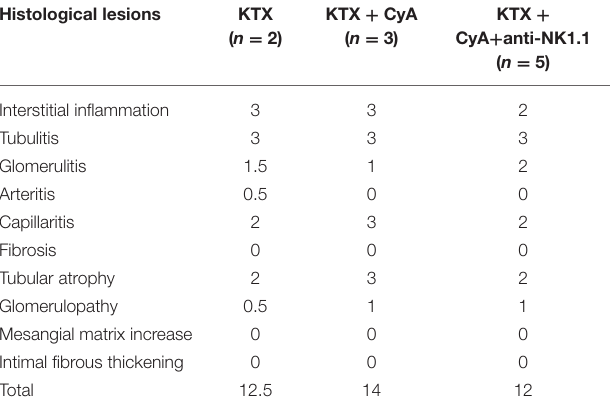
TABLE 1 | Histopathological evaluation of renal allografts in the mice surviving until POD56 using standard Banff Classification (median). Histological